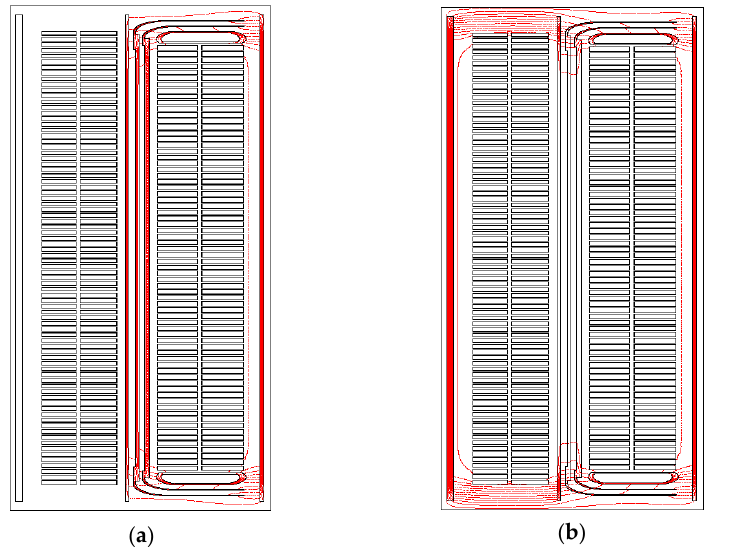
Figure 6. The equipotential lines under two typical DC voltage applying methods. ( a ) Voltage applied on high voltage winding; ( b ) Voltage applied on both windings.